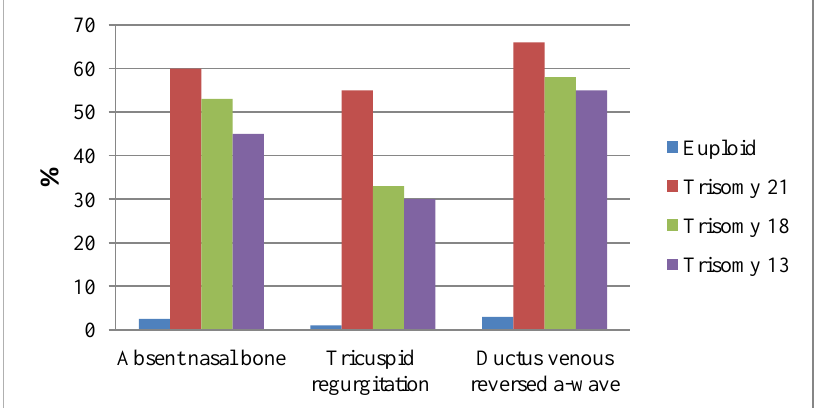
Figure 4. Sonographic features of trisomies 21, 18 and 13 (adapted from